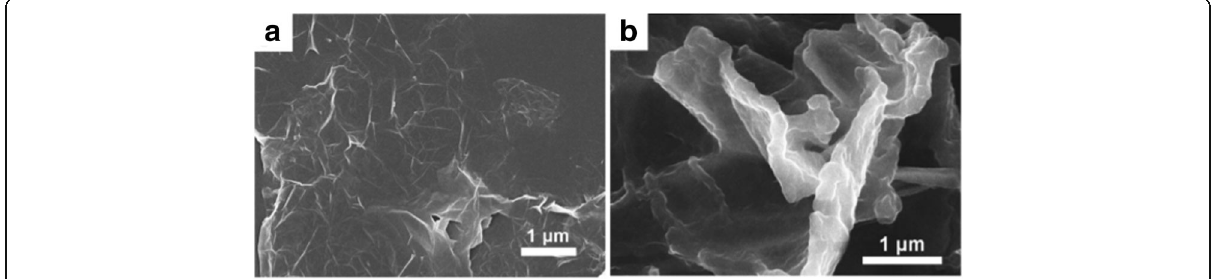
Fig. 8 SEM images of ( a ) pure RGO film ( b ) RGO, and PEDOT composites film. Reprinted with permission from [57]. Copyright 2013 Royal Society of